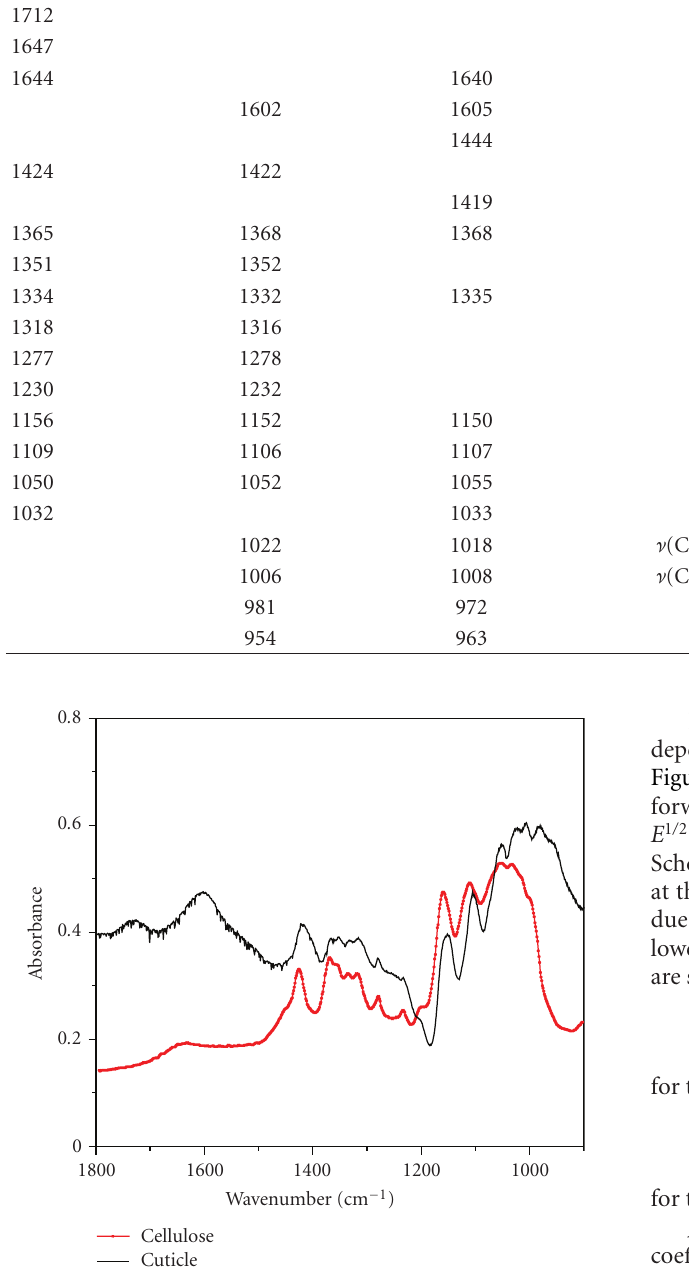
Figure 2: Absorbance FTIR spectra of the cuticle in comparison to that of